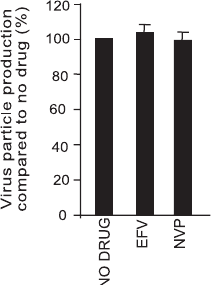
Figure 8. Effect of EFV on Mo-MuLV Particle Production 293 T cells were transfected with Mo-MuLV proviral DNA and treated as described in Figure 6, except that cell lysates were immunoprecipitated with a Mo-MuLV CA antibody. All drugs were tested at 5 l M. Viral particle production was quantified as described in Materials and Methods. Data represent at least three independent experiments and are expressed as the mean 6 standard